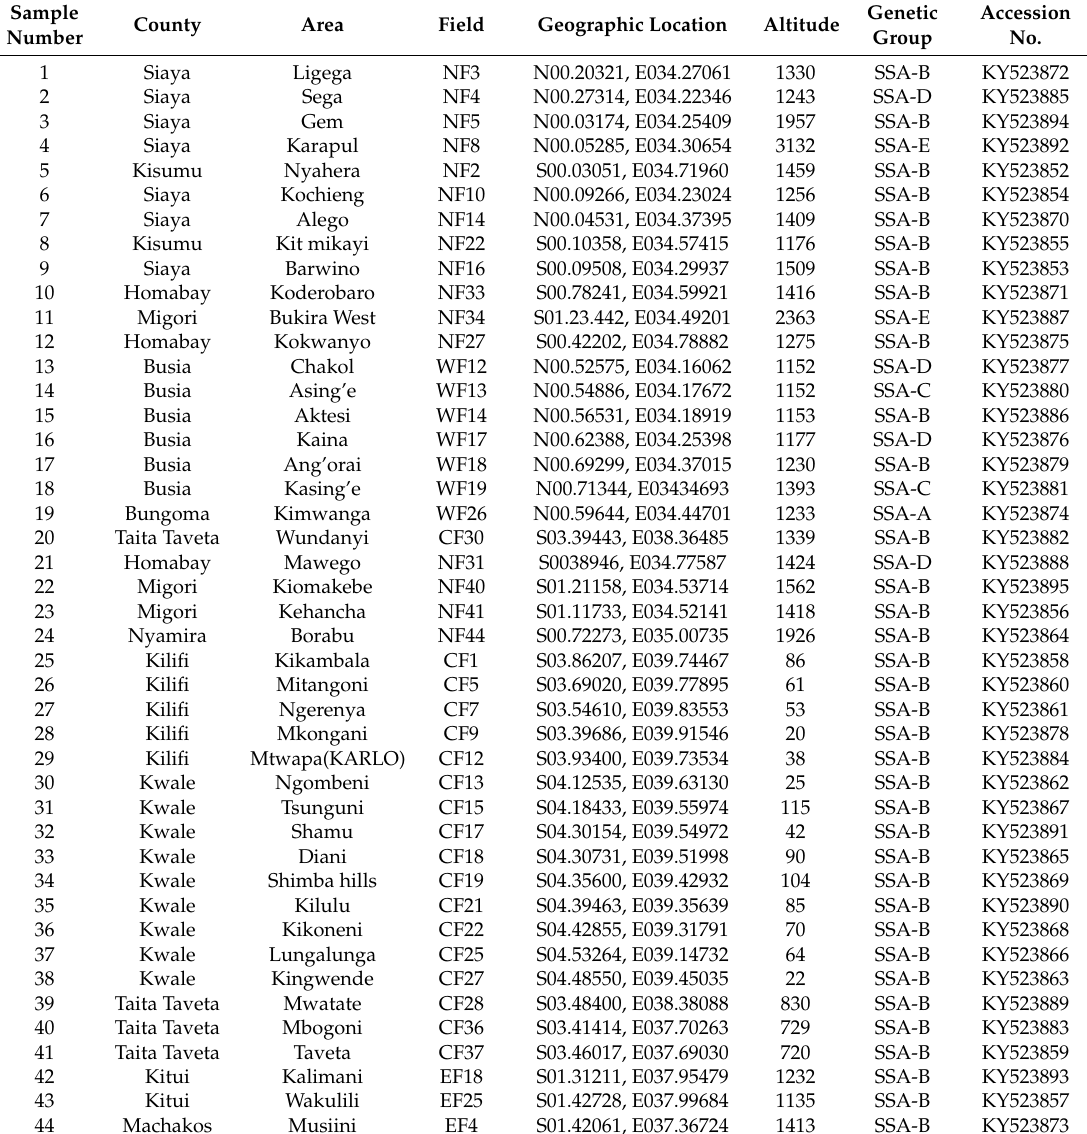
Table 1. Summary B. tabaci collected in Kenya and used in this study. These data are also mapped onto Figure 2, and there is an interactive map found at http://beta.whiteflybase.org/datamap/. Sample